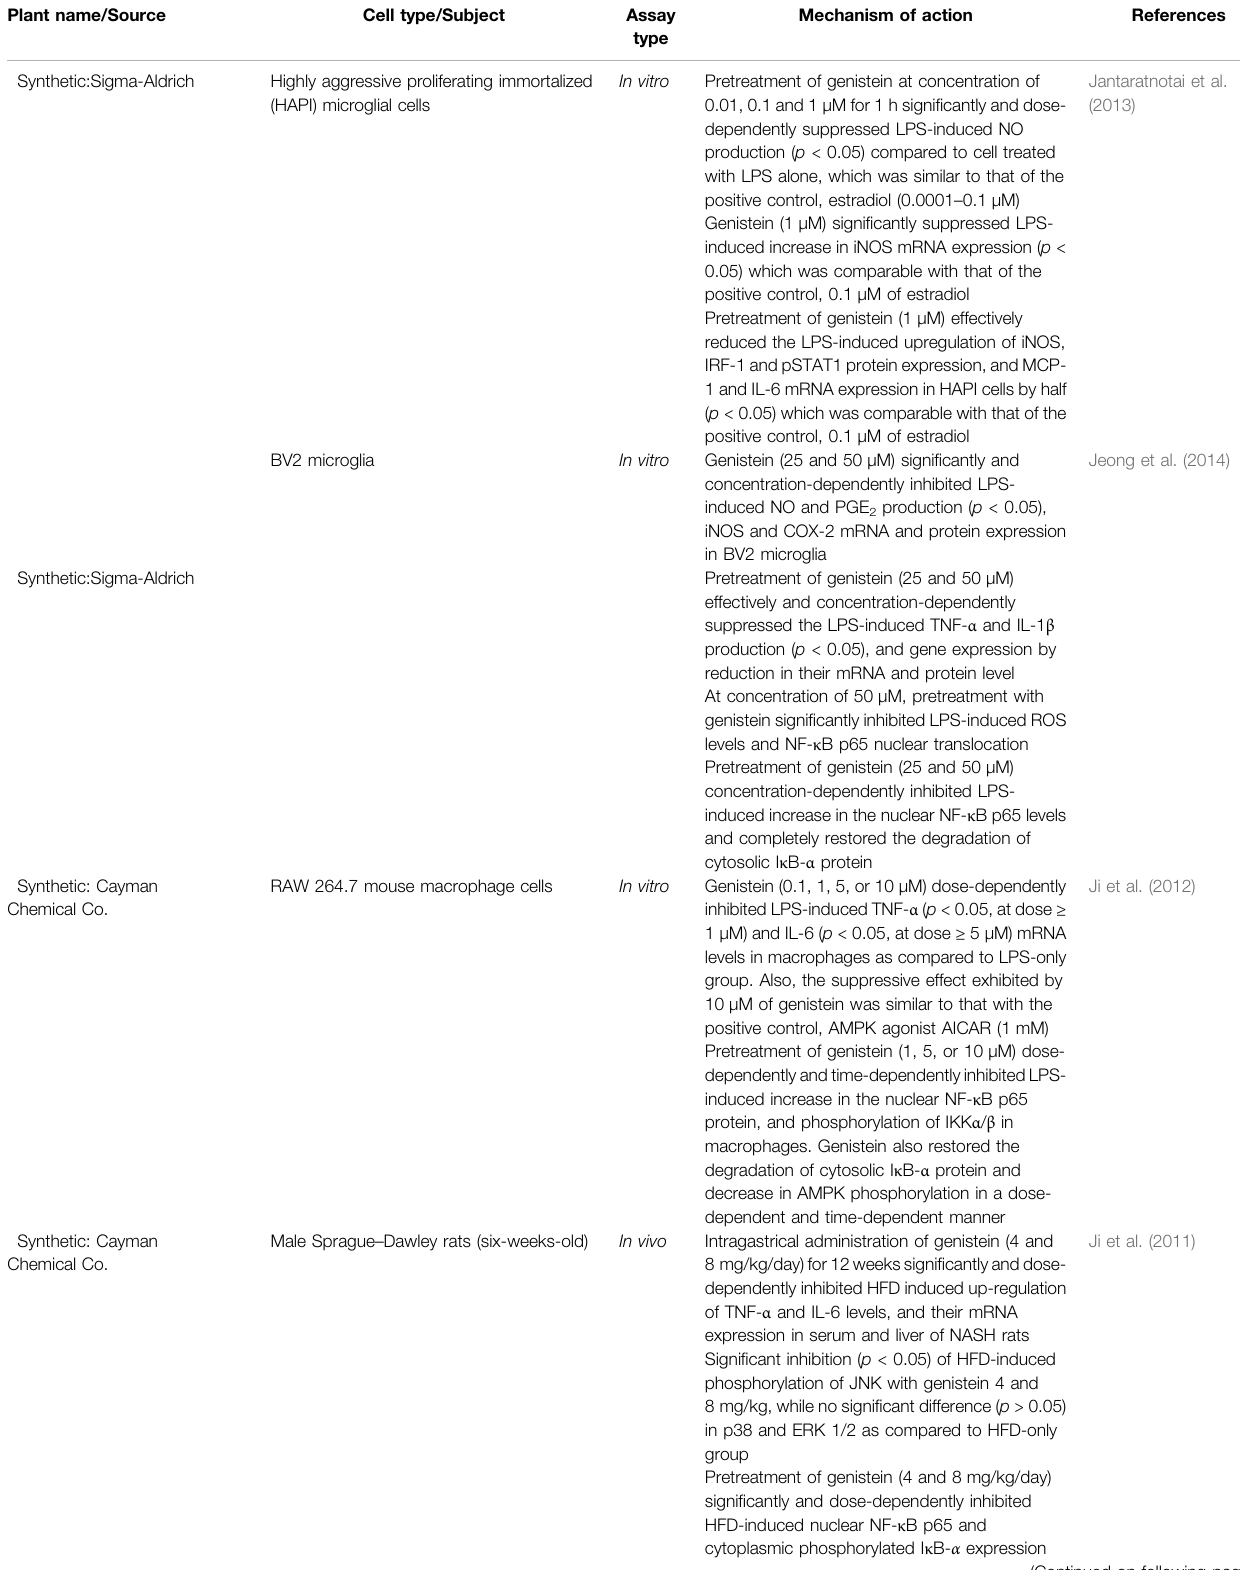
TABLE 1 | ( Continued ) Genistein with potent anti-in fl ammatory